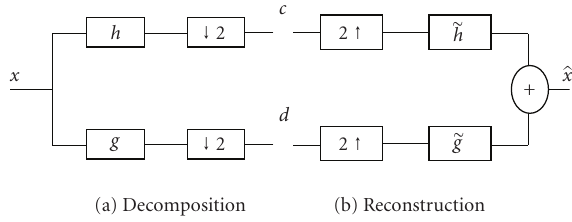
Figure 1: 1D wavelet decomposition and